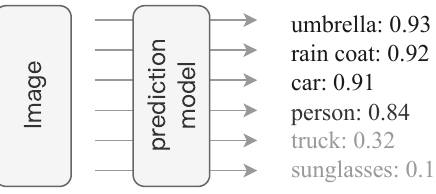
Figure 1. As shown in the above figure, the left side represents the prediction value of image ( I k ) obtained through the prediction model, and the right side represents the predicted value of the image with perturbations ( I k + δ ) obtained through the prediction model. The positive labels in the clean image include: umbrella, rain coat, car and person; negative labels include trunk and sunglasses. We hope that our model is robust to perturbations I k + δ . For example, the car is the positive label in the real predicted value. After the perturbations are added, the predicted value of the car is still higher than that of negative